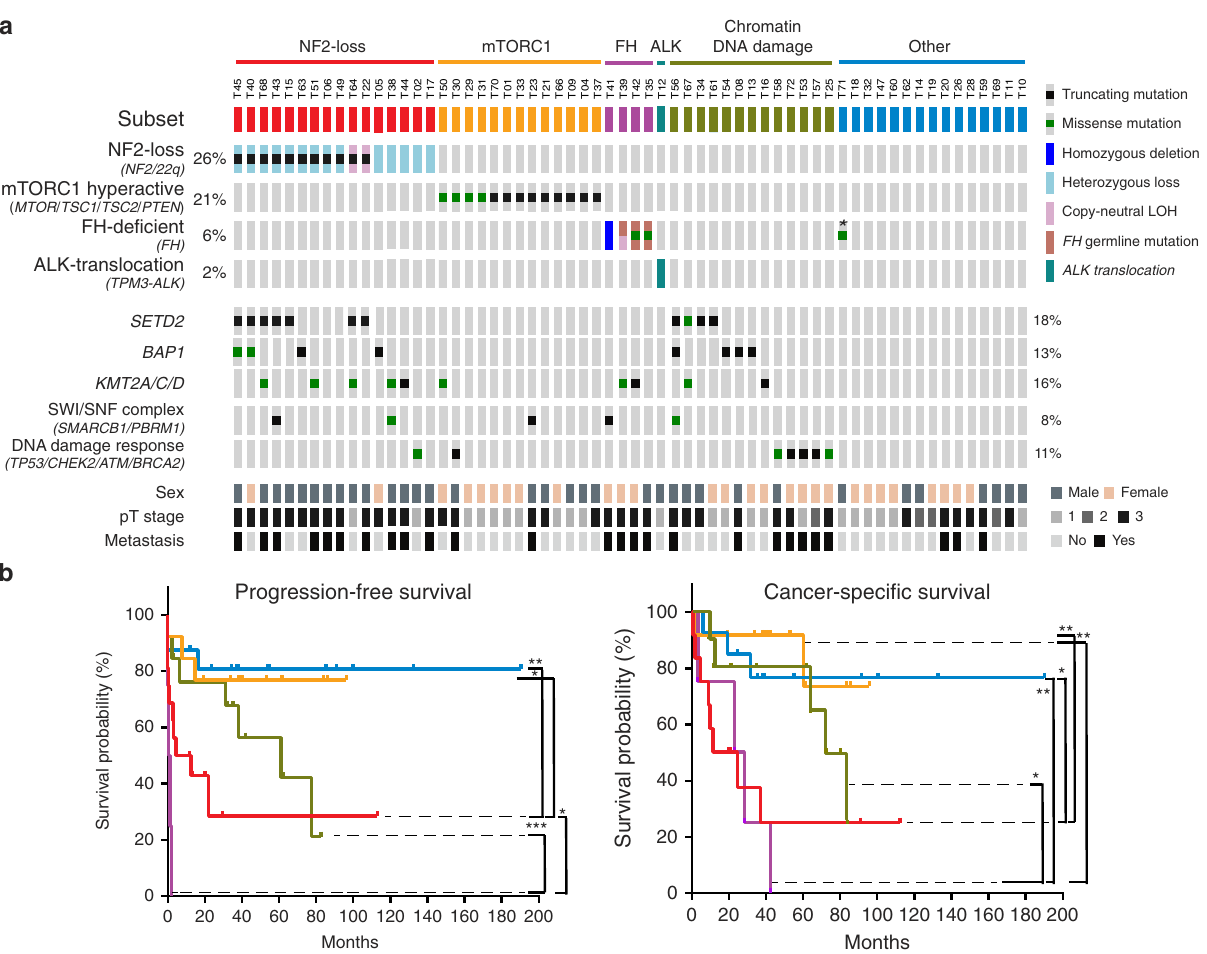
Figure 4 | Clinical outcomes associated with molecular subsets of uRCC. ( a ) Overview of molecular features and clinicopathological characteristics of uRCC subsets identified in our cohort. NF2 loss (NF2 loss, n ¼ 16), mTORC1 (mTORC1 hyperactive, n ¼ 13), FH (FH deficient, n ¼ 4), ALK ( ALK translocation, n ¼ 1), chromatin DNA damage (mutations in chromatin modulation or DNA damage response genes, n ¼ 13) and other (tumours with no identifiable recurrent molecular feature, n ¼ 15). Truncating mutations include nonsense mutations, insertions or deletions that alter the reading frame and splice-site mutations. *Indicates a FH missense mutation (G401V), likely a passenger mutation. Percentages on the left indicate frequencies of 4 distinct subsets within the uRCC cohort. Percentages on the right indicate mutation frequencies of corresponding gene(s) within the cohort. ( b ) Progression-free survival (left) and cancer-specific survival (right) associated with NF2 loss, mTORC1, FH, chromatin DNA damage and other groups are presented and colour-coded as in a . Statistical significance was determined by log-rank test. Statistical significance is indicated as *** P o 0.001; ** P o 0.01; * P o